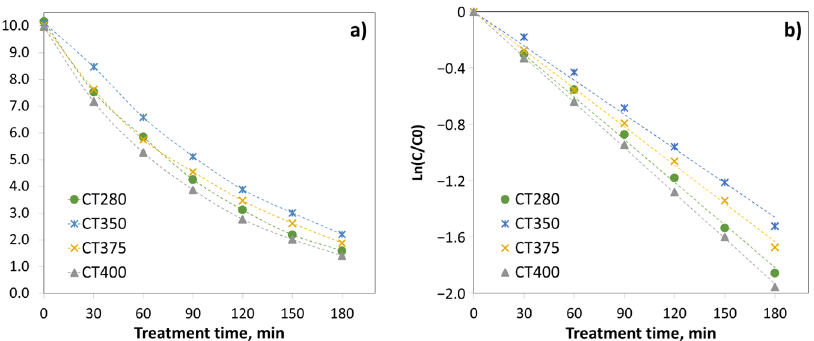
Figure 3. Photocatalytic activity of C-TiO 2 thin films under visible light irradiation: ( a ) RhB concen- tration reduction; and ( b ) the first-order degradation kinetics.